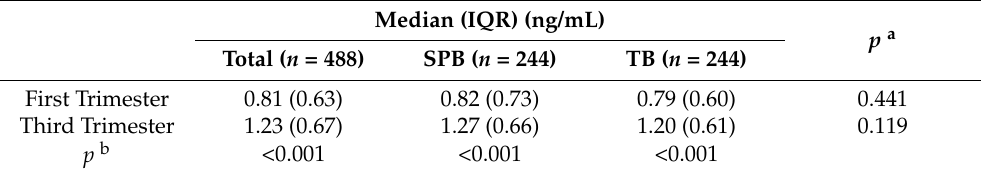
Table 2. Median Mn concentrations of women who had SPB and term